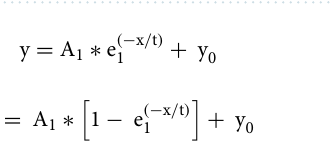
Figure 10. Microstructural parameters of β-Fe particles for all alloys and Nb contents analysed. Experimental data for size ( a ), Feret’s diameter ( b ), % area ( c ) and circularity ( d ) are shown together with the respective modeled curve. (Image J Fiji 1.46 user